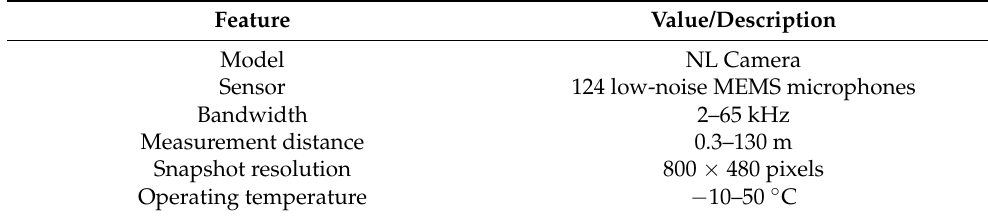
Table 2. Specifications of the sonic camera.